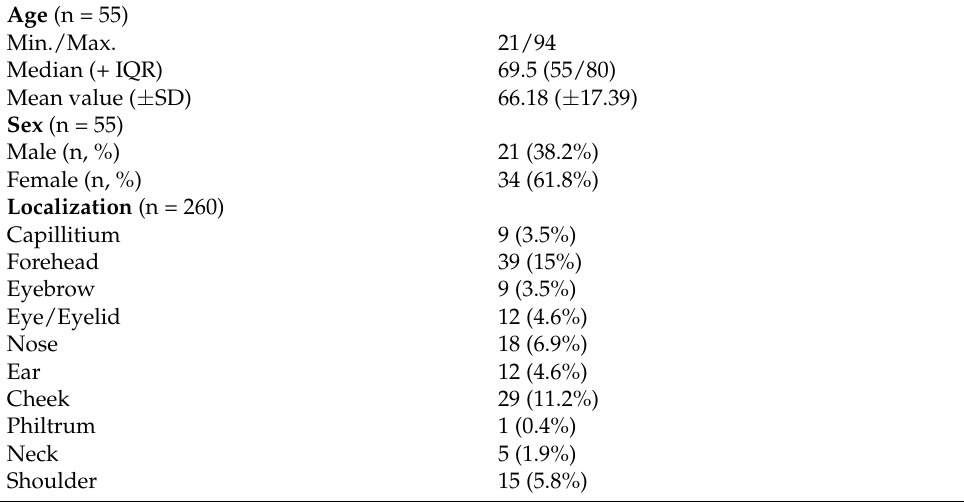
Table 1. Epidemiologic data and specimen